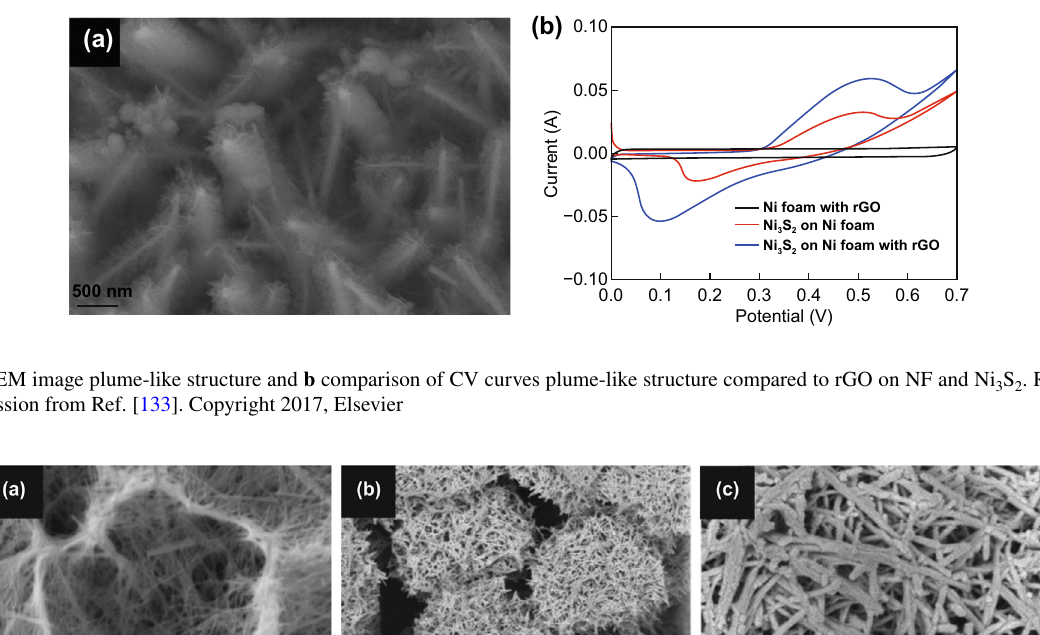
Fig. 10. Mi et al. [138] initially synthesized Ni@Ni a nest-like structure. Ni@Ni by a Co-exchange method by using Ni@Ni